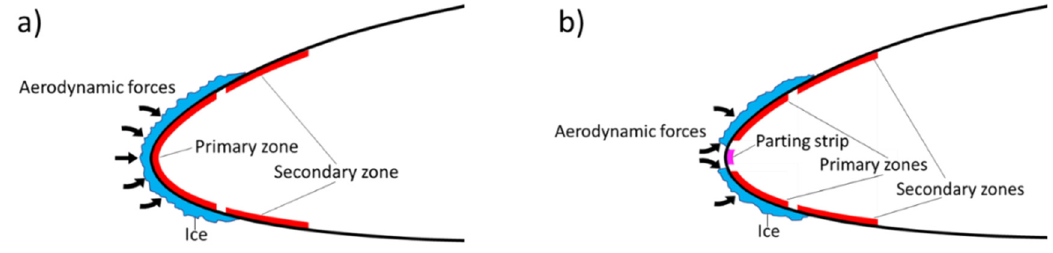
Figure 3. Schematic layout of the heating-zones for the conventional de-icing ( a ) and de-icing with a parting strip ( b ).